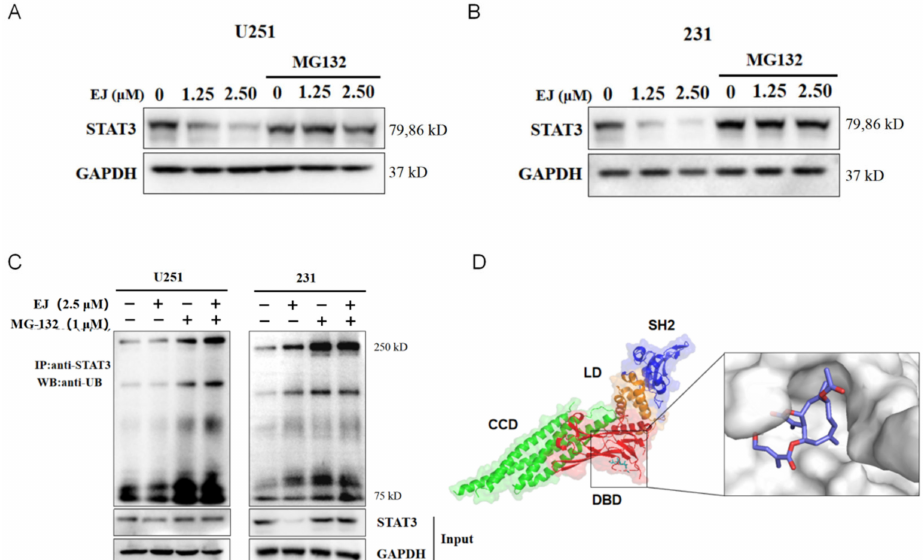
Figure 6. EJ promoted STAT3 ubiquitin-dependent degradation. ( A , B ) The ubiquitin–proteasome inhibitor MG132 reversed the inhibitory effect of EJ on the expression of the STAT3 protein in U251 ( A ) and MDA-MB-231 ( B ) cells. ( C ) EJ was found to promote STAT3 protein ubiquitination modifica- tions by immunoprecipitation. ( D ) Molecular docking results showed that EJ was able to bind to the DNA binding domain of the STAT3 protein (PDB ID: 6QHD). (CCD: coiled-coil domain, DBD: DNA binding domain; LD: linker domain; SH2: Src homology 2